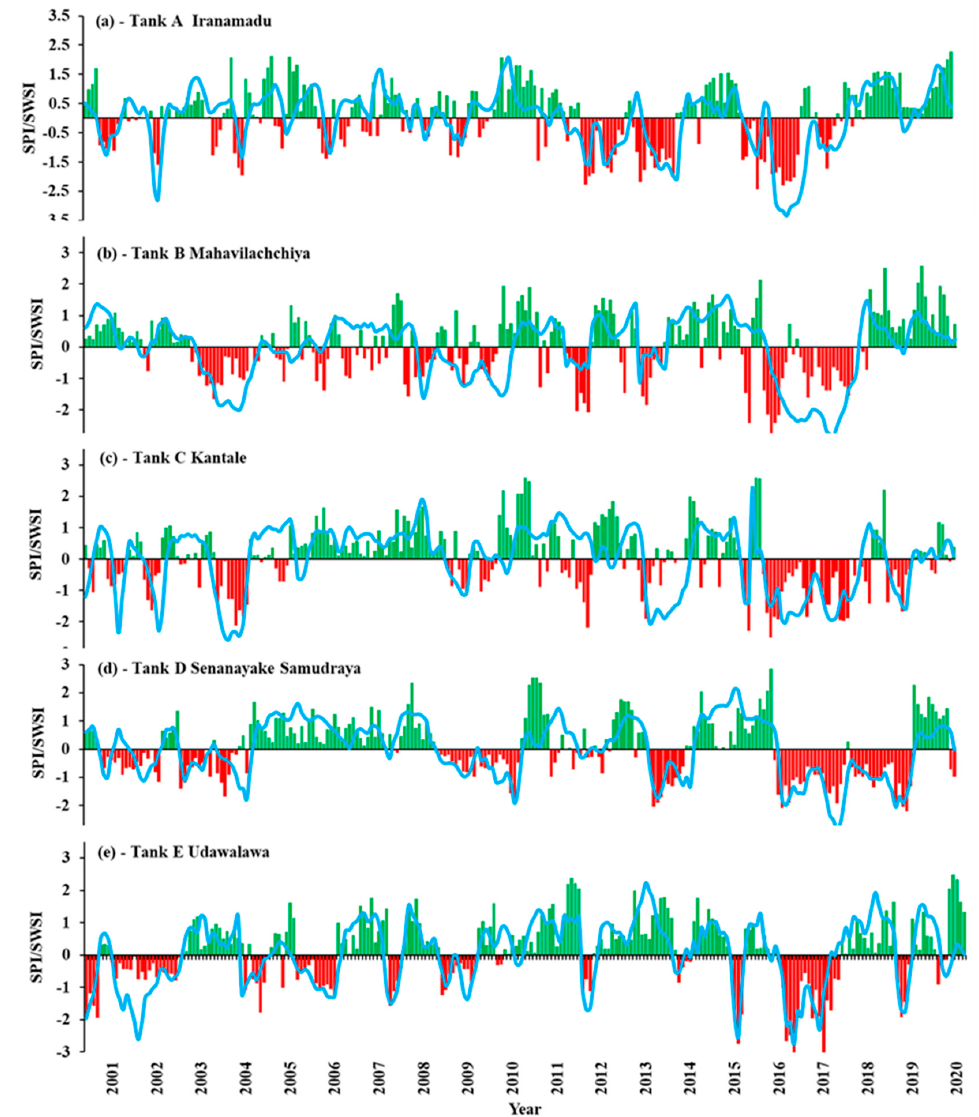
Figure 10. Variation in SPI and SWSI over time in five tanks. ( a )—Tank A (Iranamadu), ( b )—Tank B (Mahavilach-chiya), ( c )—Tank C (Kanthale), ( d )—Tank D (Senanayaka Samudraya), ( e )—Tank E (Udavalawa). The green and red bars in the graph represent positive and negative SPI values, re- spectively.